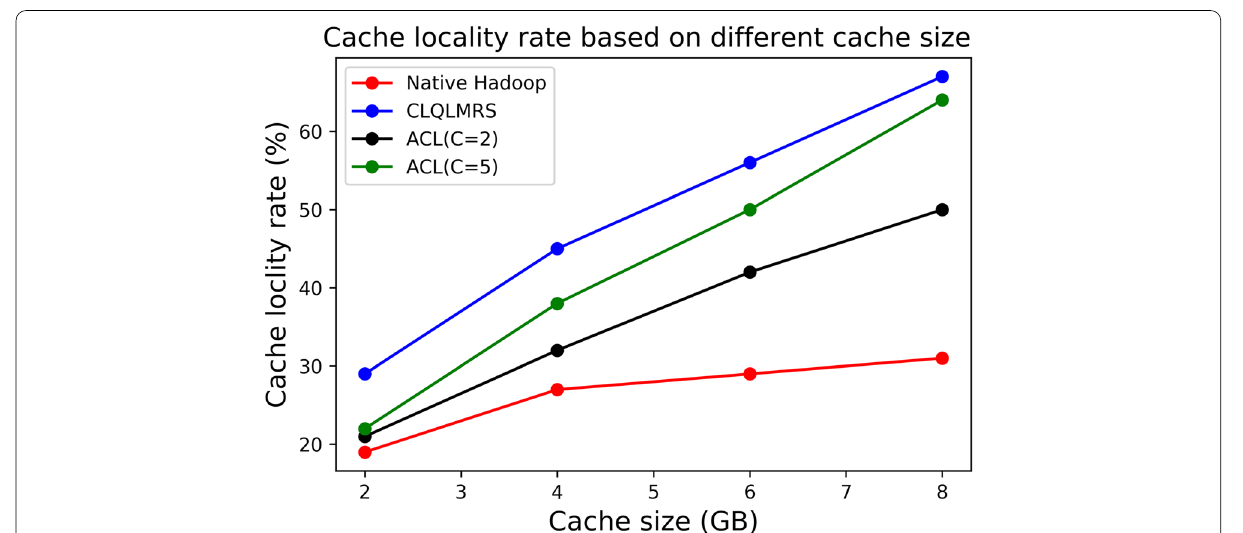
Fig. 5 Cache locality rate based on cache